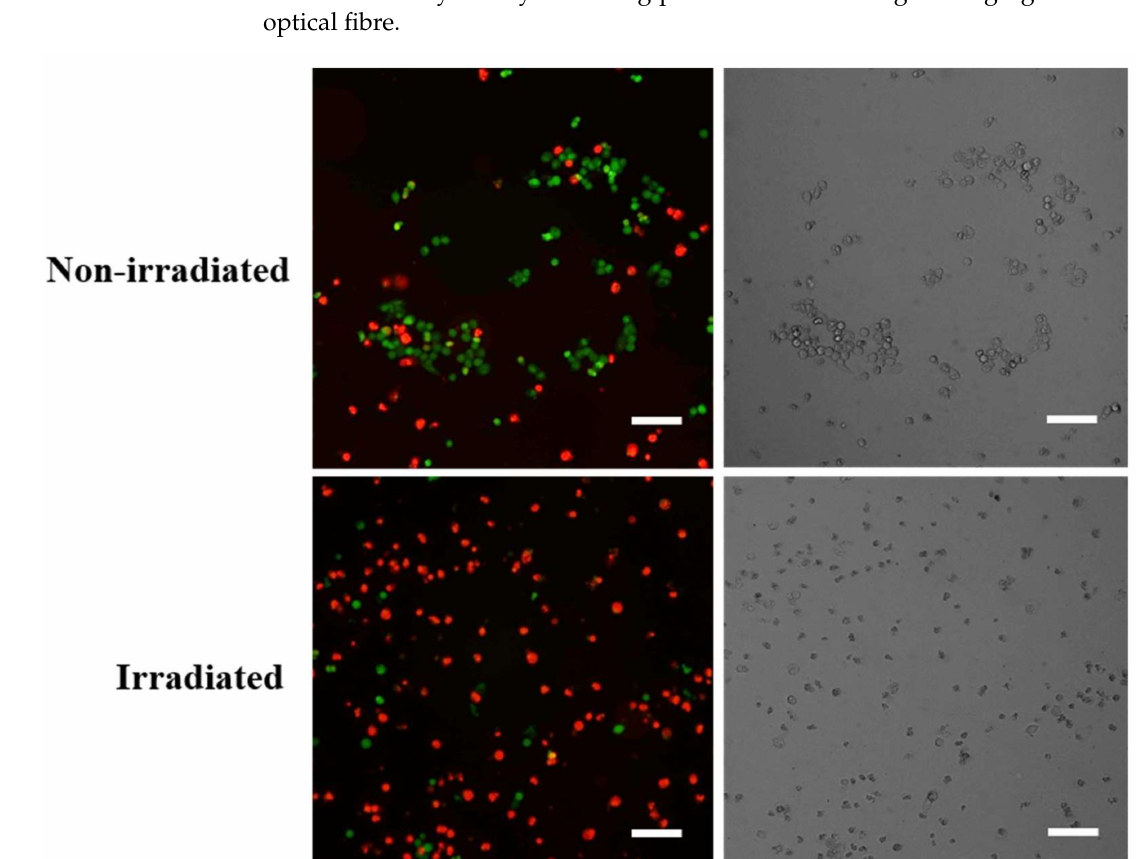
Figure 3. Fluorescent images of HCT-116 cells ( left ) stained with CAM (green) and PI (red) and brightfield images of HCT-116 cells ( right ) at 48 h post-treatment with 2 µ M 1 in both irradiated and non-irradiated states. The CAM (green) signal indicates live cells, and the PI (red) signal indicates dead cells. A higher proportion of dead cells is shown when cells were treated with the irradiated form of 1 , suggesting irradiated 1 is more active. Scale bars, 160 µ